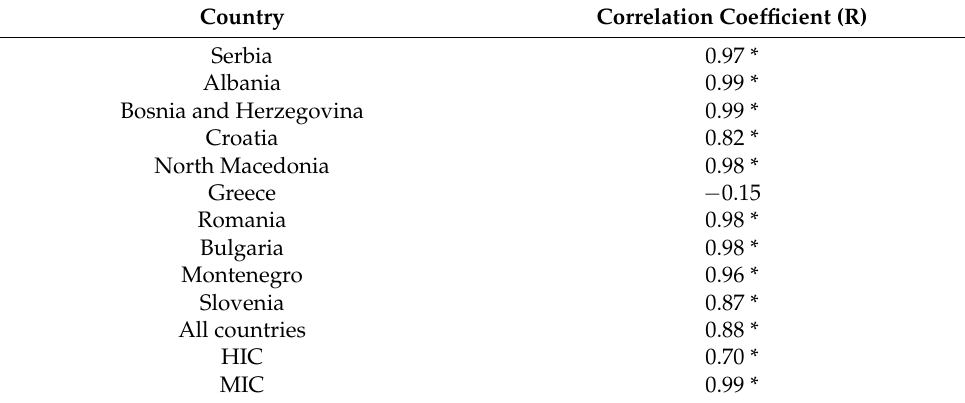
Table 6. Pearson correlation coefficient for years and GDP per country and all countries.